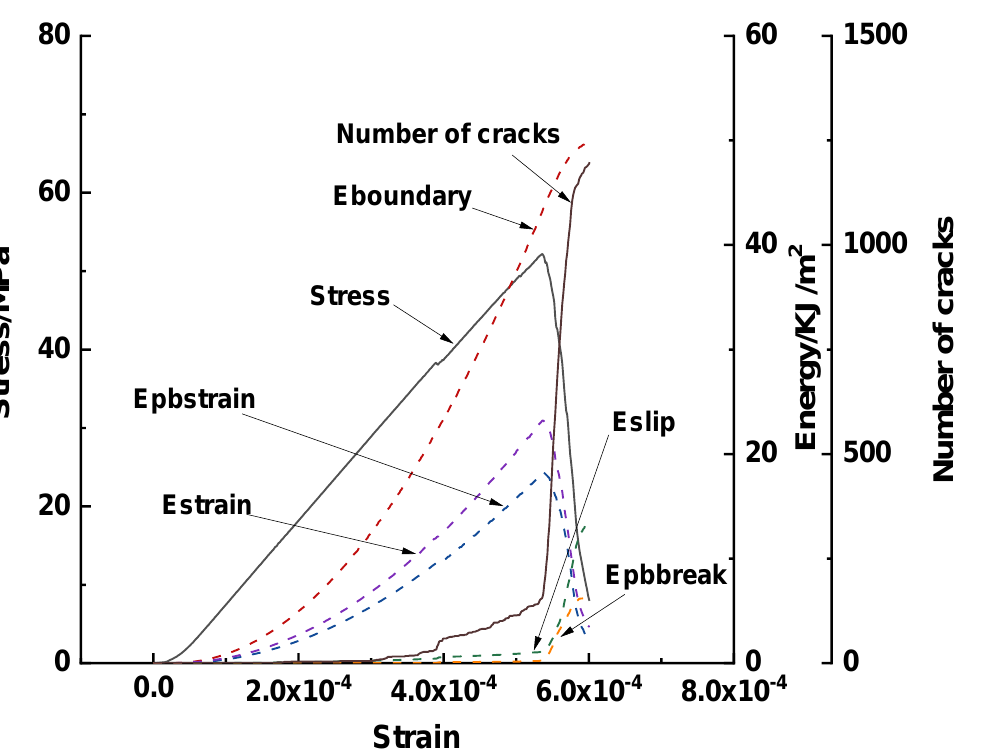
Figure 14. Energy, stress, and crack numbers with respect to strain for the case with constant interface properties.